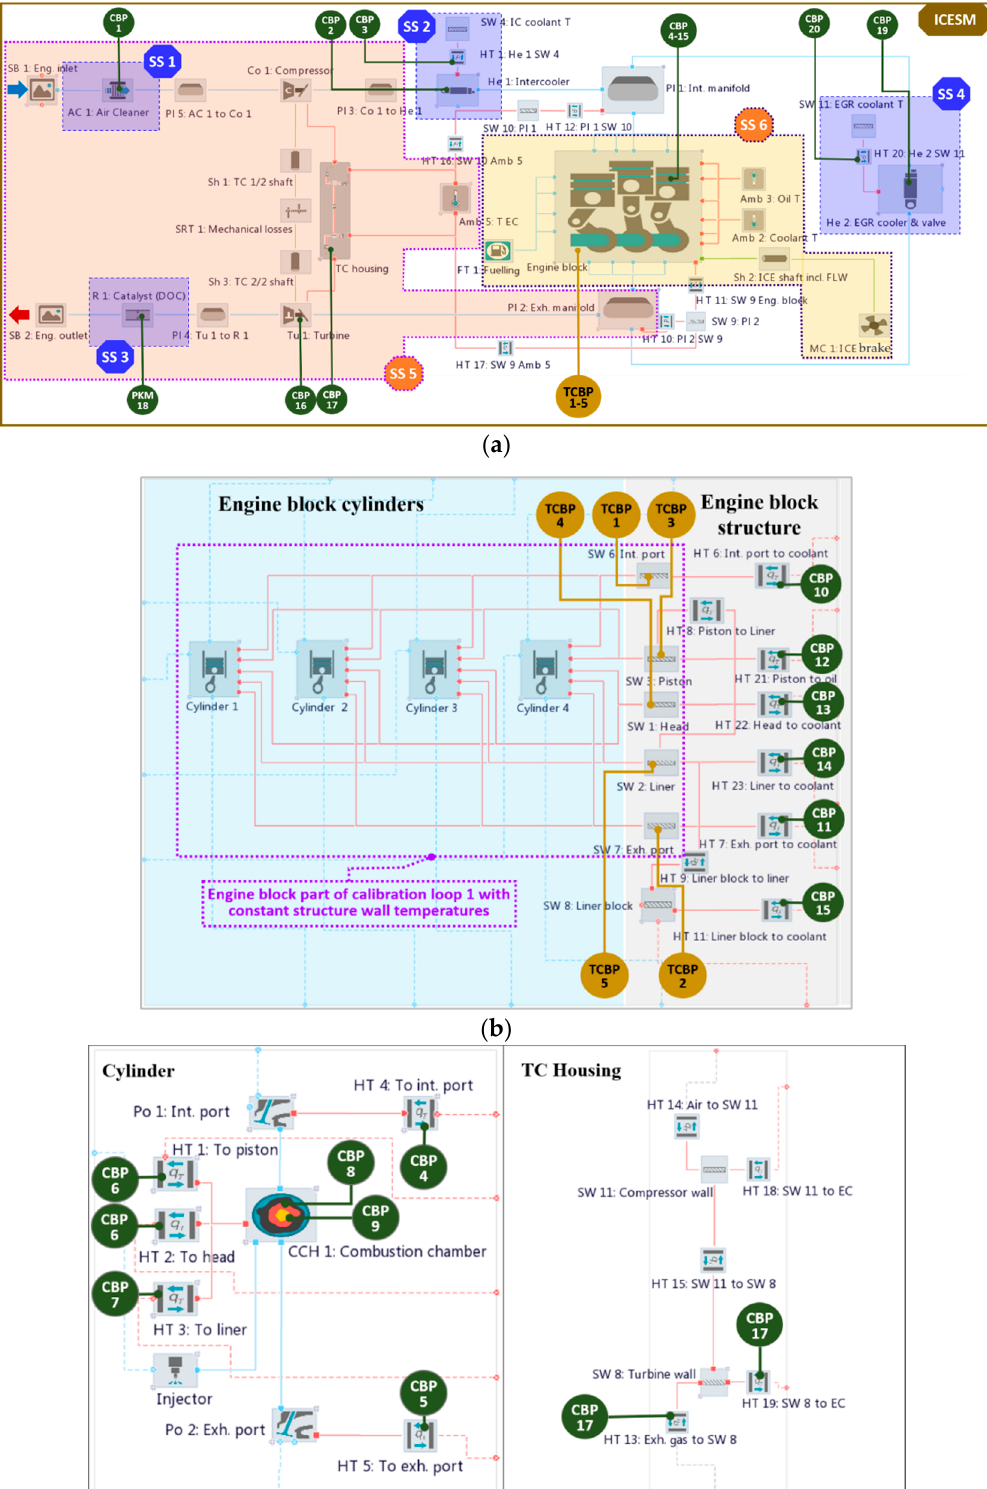
Figure 2. Division of the applied ICESM into feasible sub ‐ systems and employed CBPs labeled with green and golden ‐ yellow circles: ( a ) Air cleaner (SS 1), intercooler (SS 2), catalyst (SS 3), EGR cooler (SS 4), turbocharger (SS 5), engine block (SS 6) and all CBPs; ( b ) Division of engine block structure into two heat transfer domains, i.e., with constant and variable wall temperature approach and corresponding CBPs; ( c ) CBPs within cylinder and turbocharger housing.